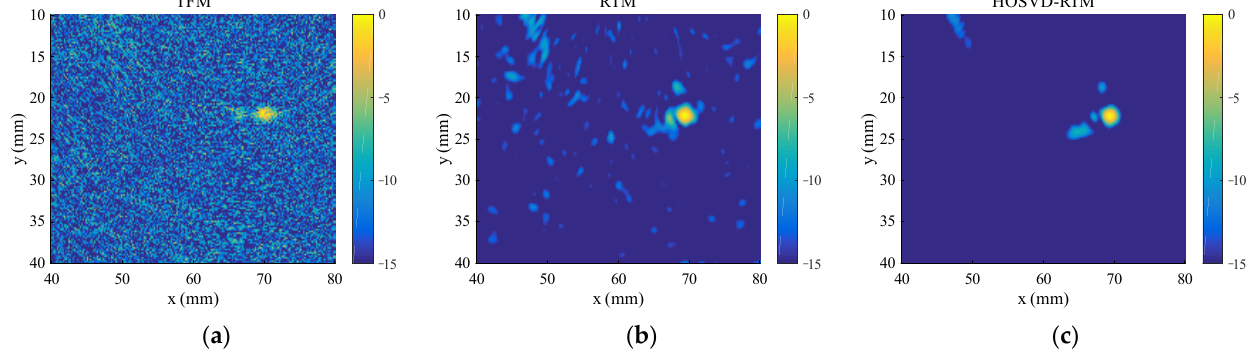
Figure 10. Imaging results obtained with the array composed of 16 elements and different algorithms. ( a ) TFM; ( b ) RTM; ( c ) HOSVD-RTM. It can be seen that HOSVD-RTM is still valid, even though the linear array has fewer elements. The imaging effect of HOSVD-RTM is significantly better than that of both RTM and